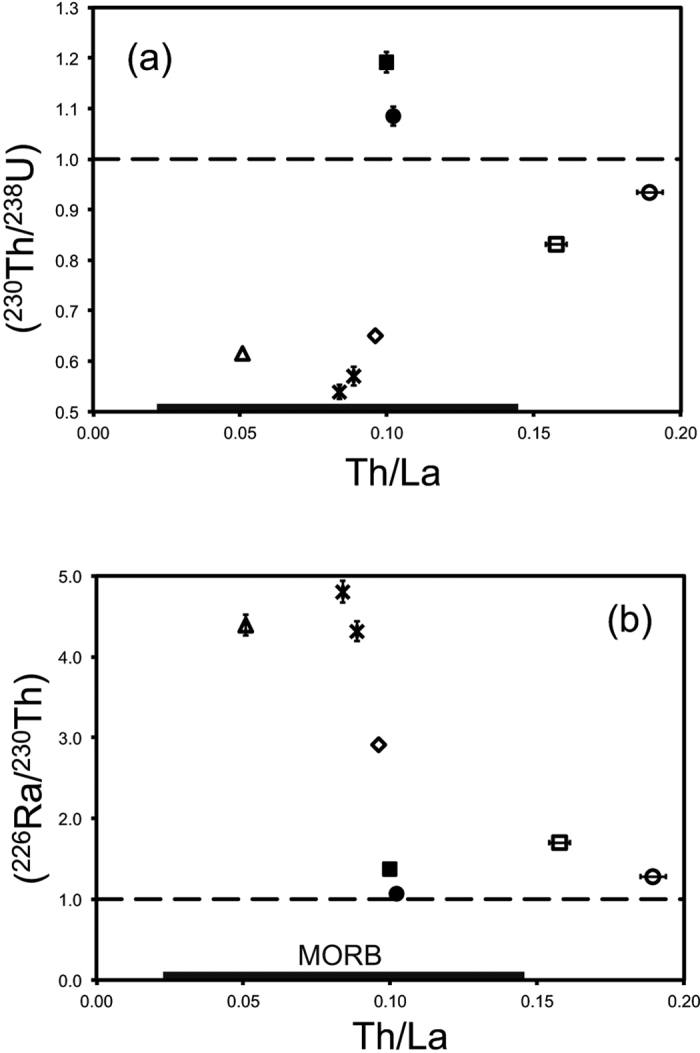
Plots of (a) (230Th/238U) and (b) (226Ra/230Th) against Th/La for samples listed in Table 2. The black bars represent the range of Th/La in MORB glasses42.For samples from western Pacific arcs, the low (230Th/238U) and high (226Ra/230Th) values associated with samples with high Th/La suggests that these ratios largely reflect the degree to which Th is mobilized from the subducting plate. Symbols as in Fig. 1. Error bars are illustrated for values larger than the sample symbols.